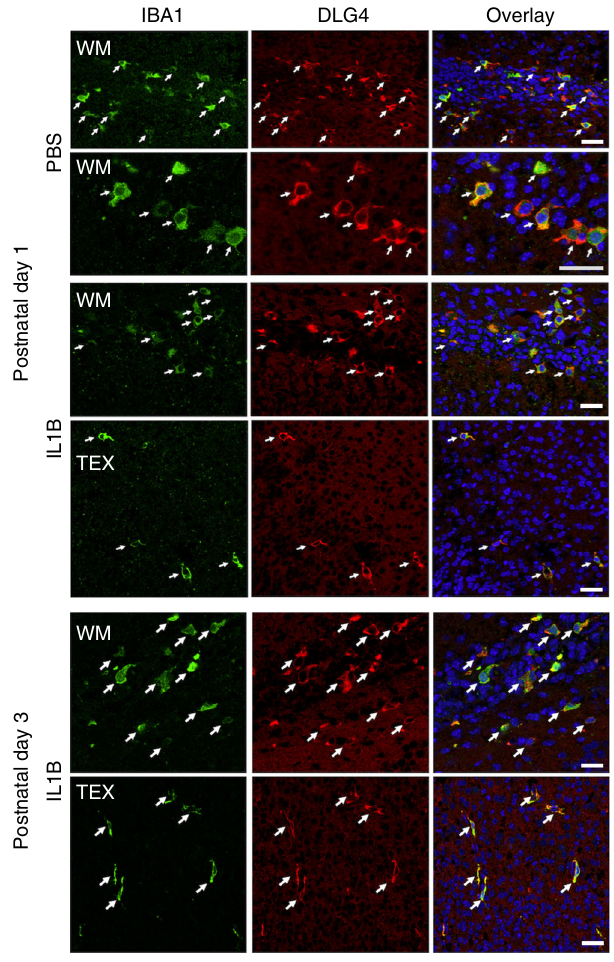
Fig. 4 Effects of exposure to neuroin fl ammation on DLG4 expression in mouse microglia in vivo. Double labelling of MACS-isolated mouse microglia (IBA1+) and DLG4 (PSD95) under control (PBS) and in fl ammatory (IL1B) conditions in the subcortical white matter (WM) and sensorimotor cortex (TEX). IBA1 and DLG4 were exclusively co-localised ( arrows ) at P1 in both PBS and IL1B mice but at P3 IBA1 and DLG4 co-localisation ( arrows ) was observed only in IL1B mice, not in control (PBS) mice. Scale bars = 30 µ